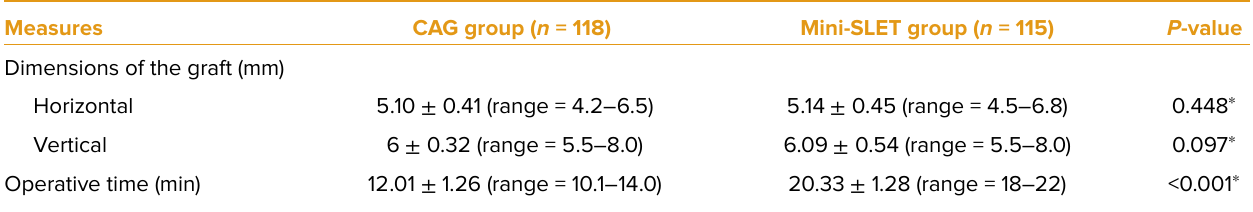
Table 2. Comparison of the size of the graft and operative time between the CAG group and mini-SLET group